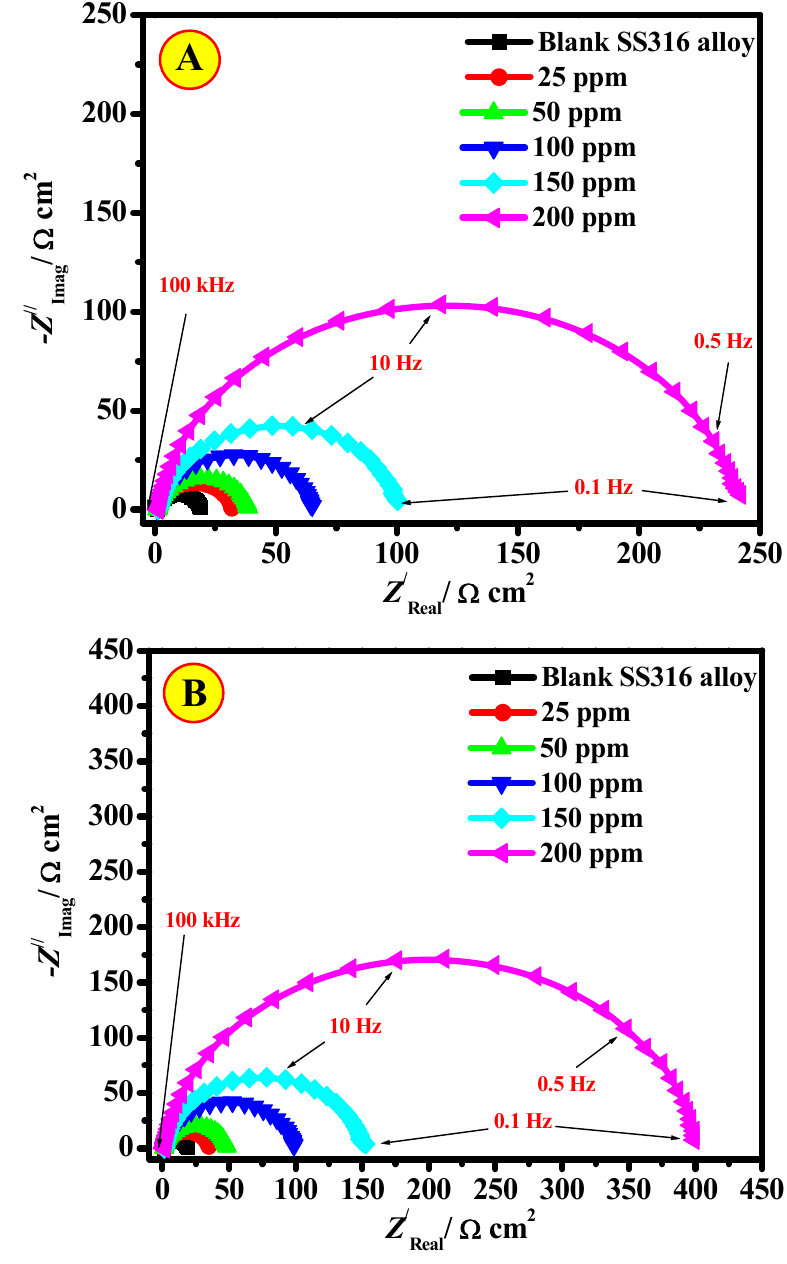
Figure 8. Nyquist diagrams of SS316 alloy in 2.0 M HCl in the absence and the presence of various concentrations of ( A ) CEL and ( B ) NCC, at T = 323 K.